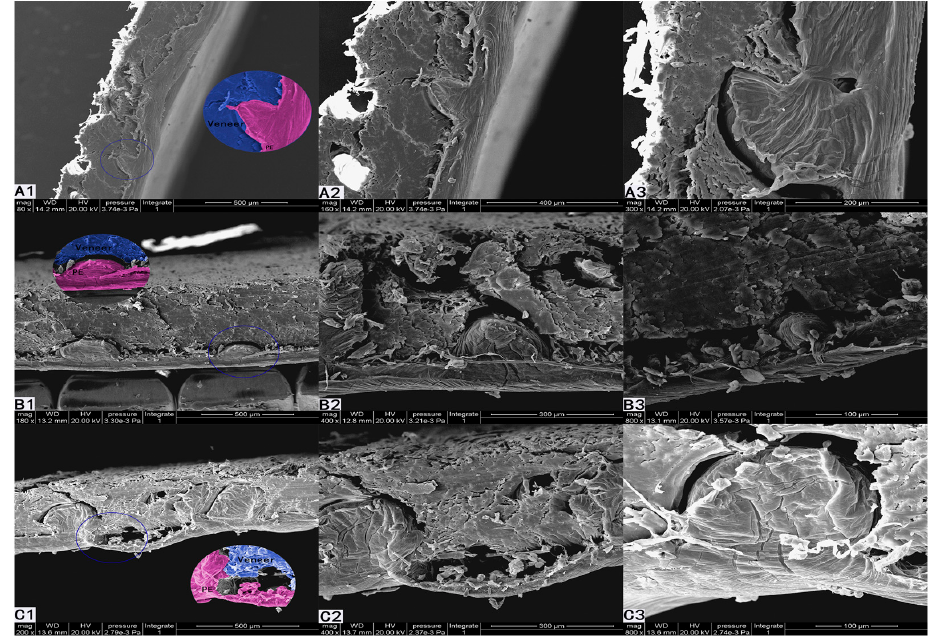
Figure 4. Bonding interface between PE film and Fraxinus mandshurica veneer with different initial MC. ( A1 )17% , ×80; ( A2 )17% , ×160; ( A3 )17% , ×300; ( B1 ) 20%, ×180; ( B2 ) 20%, ×400; ( B3 ) 20%, ×800; ( C1 ) 50%, ×200; ( C2 ) 50%, ×400; ( C3 ) 50%,